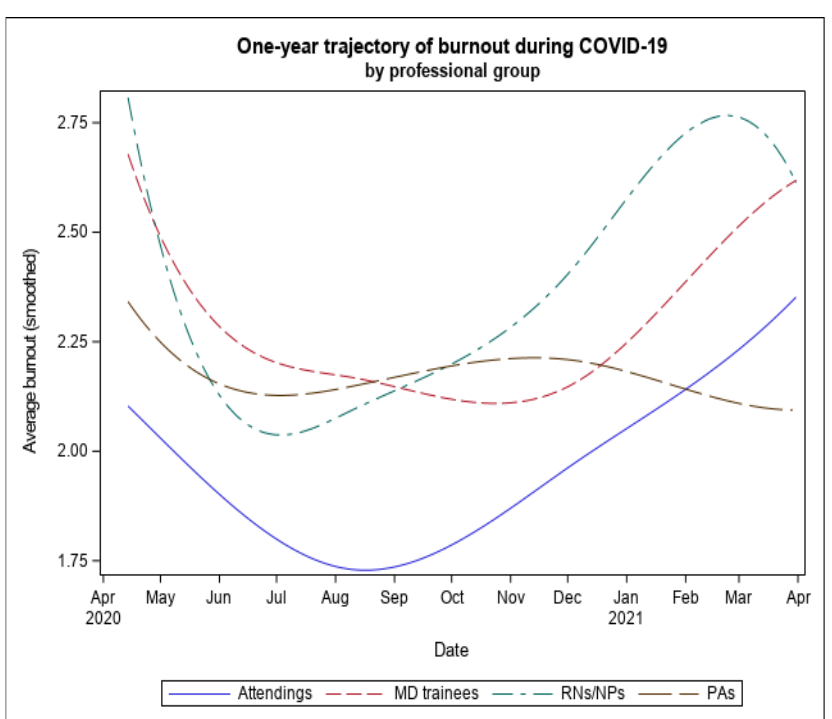
Figure 3. The one-year trajectory of burnout by Professional Role.